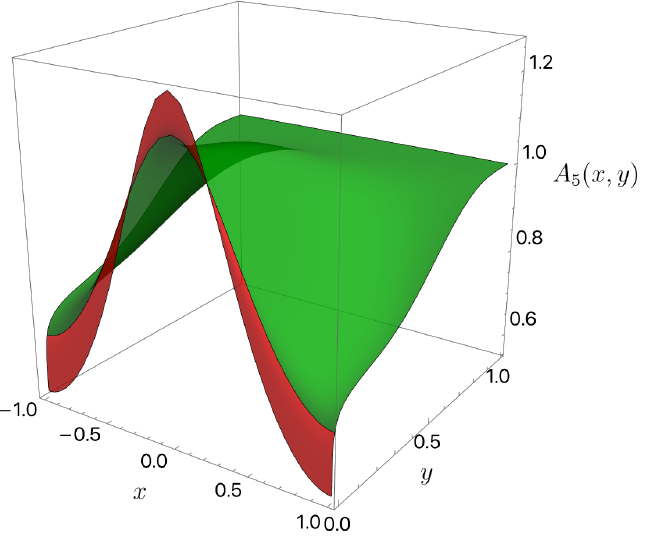
Figure 10 . A plot showing A 5 ( x, y ) as a function of ( x, y ) with 4 πLT = 10 − 8 , ¯ µ = 1 . 26244 , µ 2 = − 0 . 5 and µ ‘ = 0 , for ‘ 6 = 2 . In this case y c = 10 − 2 , and the patch near the horizon is represented in red and the one away from the horizon in